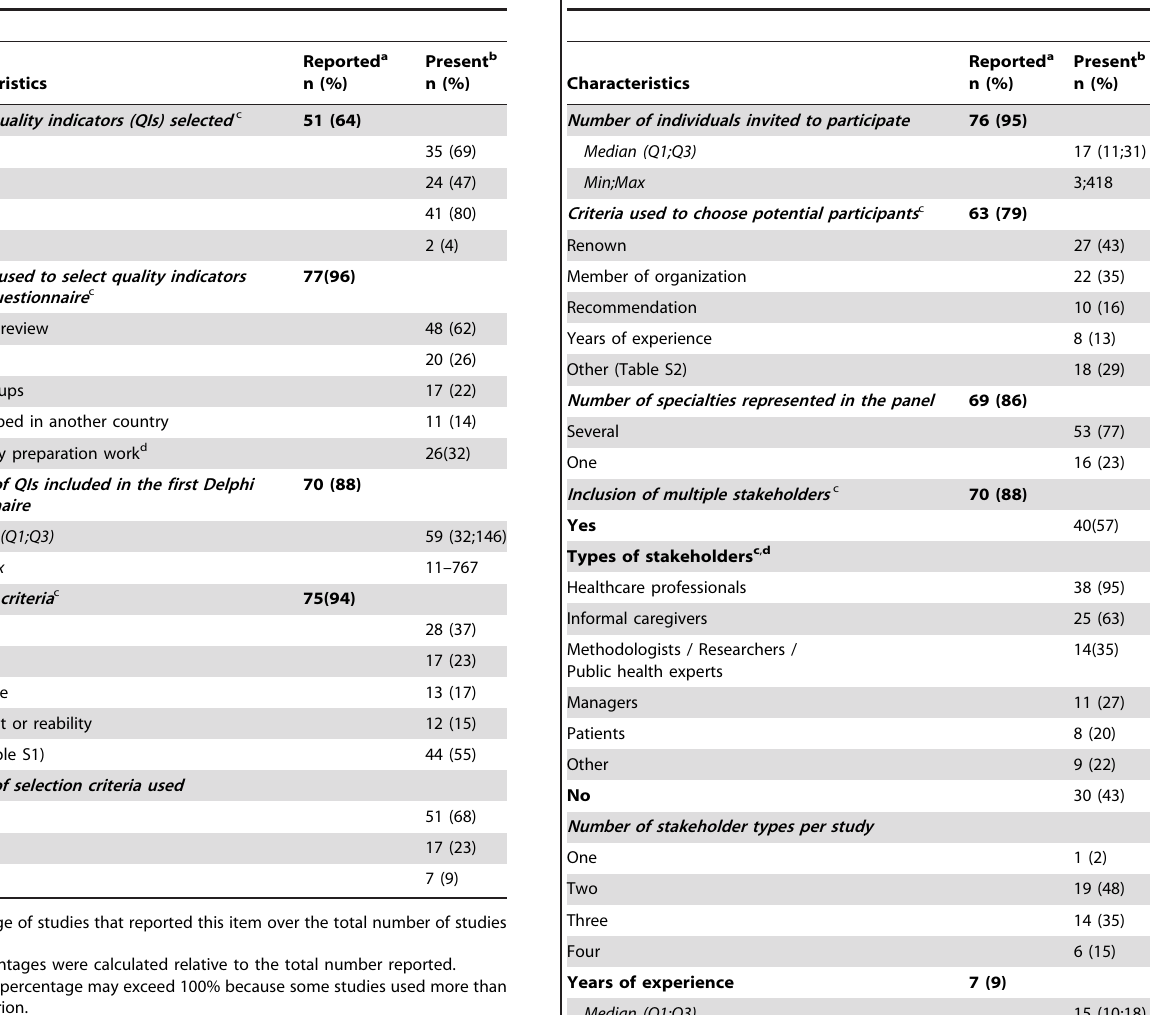
Table 2. Characteristics of the first Delphi questionnaire. Table 3. Description of the Delphi